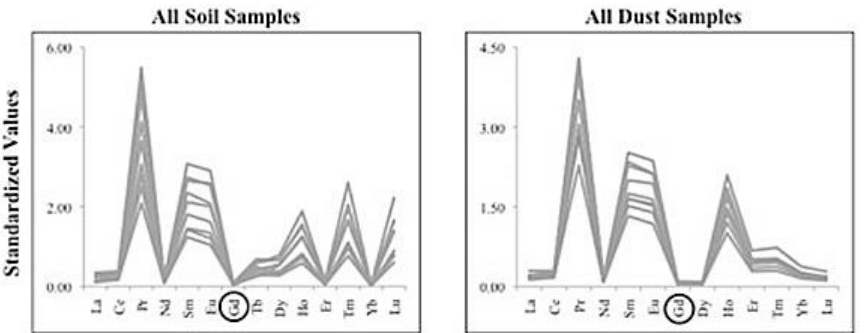
Figure 3. Standardized soil and dust samples from all sampling locations showing negligible amounts of Gd relative to other